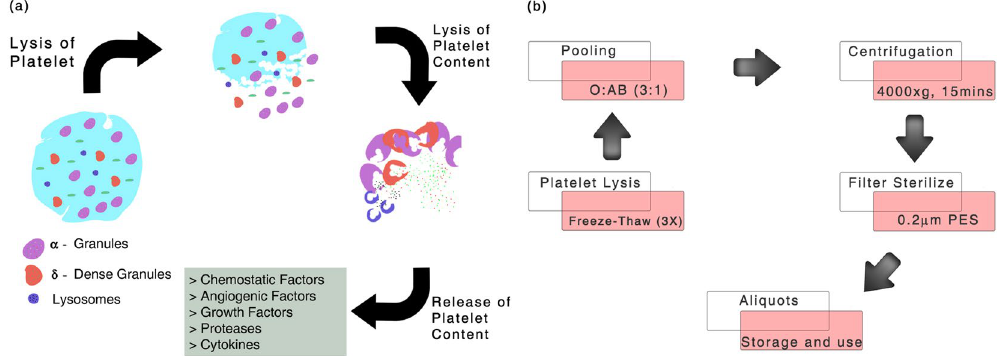
Figure 1. Platelet content and preparation of pooled human platelet lysate (pHPL). ( a ) Illustration showing the release of platelet granule contents which include cytokines, angiogenic factors, proteases and chemostatic factors on lysis ( b ) Overview of freeze-thaw mechanism of platelet lysate preparation, pooling and long-term